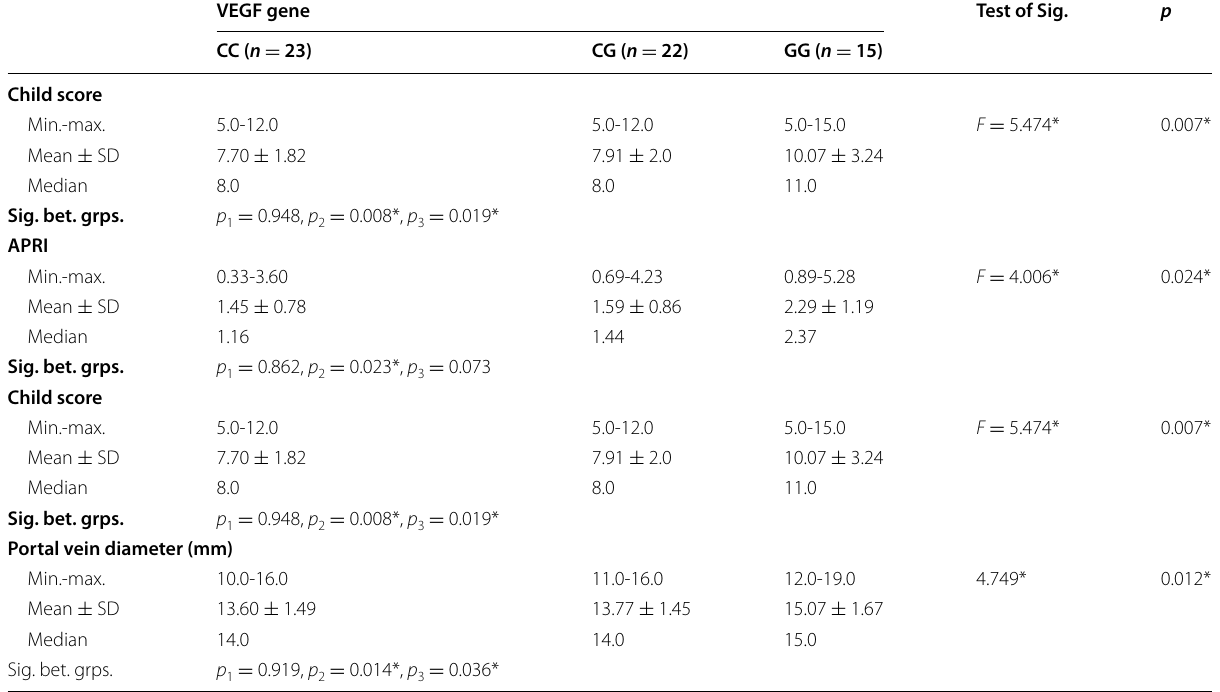
F F for ANOVA test, H H for Kruskal-Wallis test, p p value for comparing between different categories